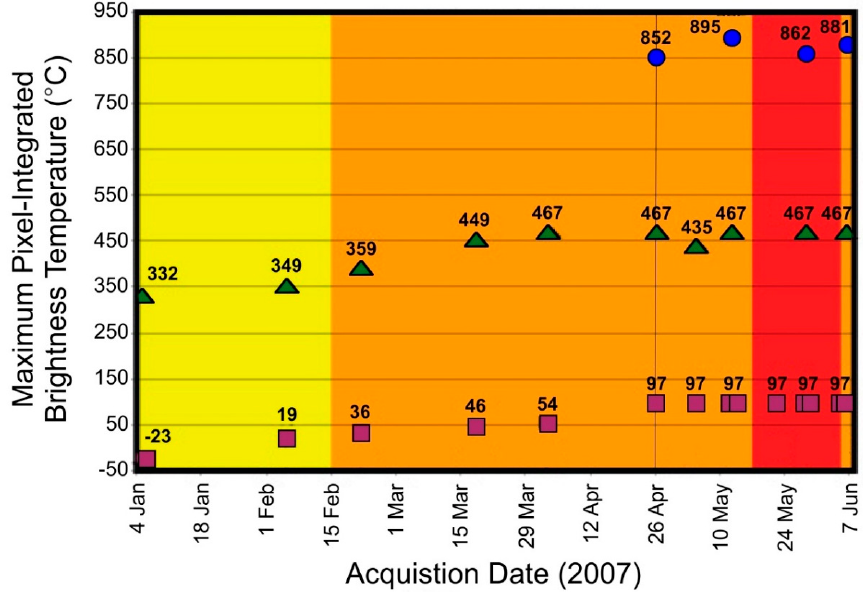
Figure 5. Maximum ASTER-derived pixel-integrated brightness temperatures detected during the 2007 eruption of Klyuchevskoy volcano, Russia. Thermal infrared (TIR) temperatures are denoted with purple squares; shortwave infrared (SWIR) temperatures with green triangles; and visible/near-infrared (VNIR) temperatures with blue circles. The background colors represent the volcanic color code issued by the monitoring agencies (yellow = elevated unrest above known background levels; orange = heightened unrest with increased likelihood of eruption; red = eruption is forecast to be imminent). TIR and SWIR temperatures become saturated (and VNIR temperatures become measureable) near the time shown by the thin vertical line. This saturation indicates that a significant amount of highly radiant lava is on the surface and occurred despite adjustments to the SWIR gain settings. Importantly, this was more than two weeks before the color code is changed to red. Modified from Rose and Ramsey [43].